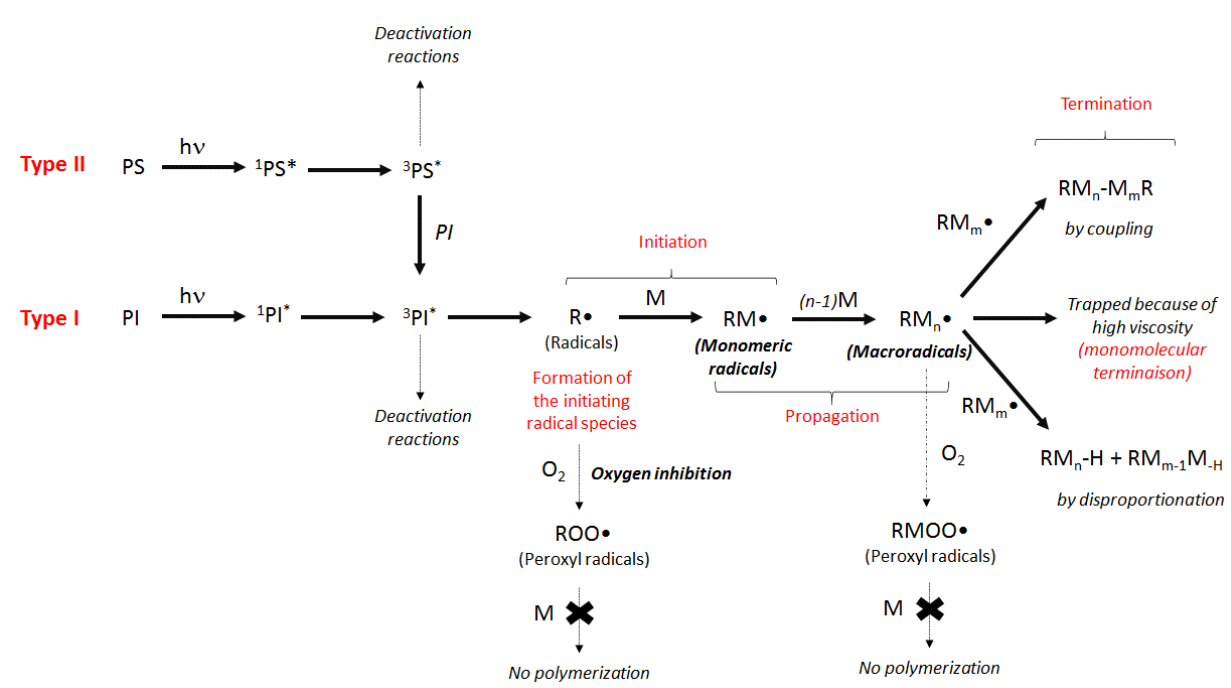
Figure 3. Overall mechanism of free-radical photopolymerization (FRP) with and without oxygen under light activation.